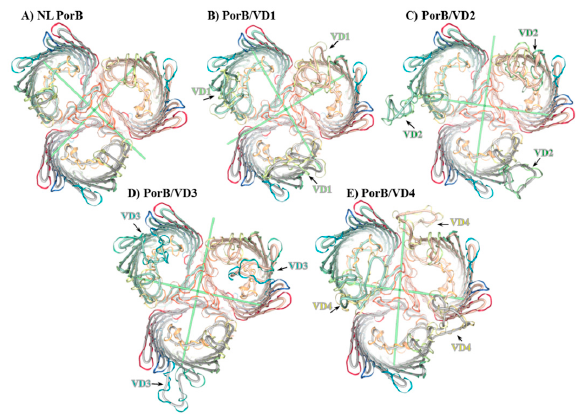
Figure 2. Molecular representation of PorB/VDs. Cartoon of predicted trimers (top view) created with Swiss-Model server [63,64] and NGL Viewer 0.9.0 [65] based on the Nme PorB template (PDB ID 3WI4) [66]. Loops are depicted as follows: L1: Red. L2: Orange. L3: Ochre. L4: Yellow. L5: Lime green. L6: Green. L7: Teal. L8: Blue. ( A ) NL PorB; ( B ) PorB/VD1: NL PorB L5 (lime green) is replaced with MOMP L2 containing VD1; ( C ) PorB/VD2: NL PorB L6 (green) is replaced with MOMP L3 containing VD2; ( D ) PorB/VD3: NL PorB L7 (teal) is replaced with MOMP L5 containing VD3; ( E ) PorB/VD4: NL PorB L4 (yellow) is replaced with MOMP L6 containing VD4.